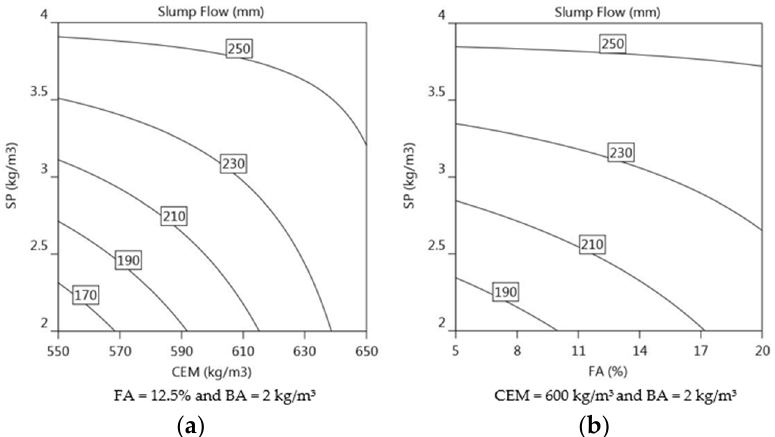
Figure 8. Isoresponse curves of slump flow showing ( a ) SP versus CEM, ( b ) SP versus